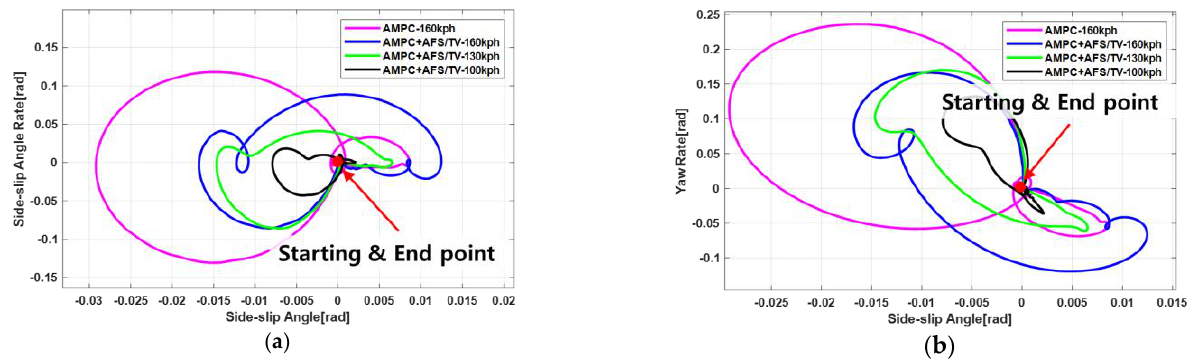
Figure 15. ( a ) Side-slip angle and side-slip angle rate trajectory and ( b ) side-slip angle and yaw rate trajectory.